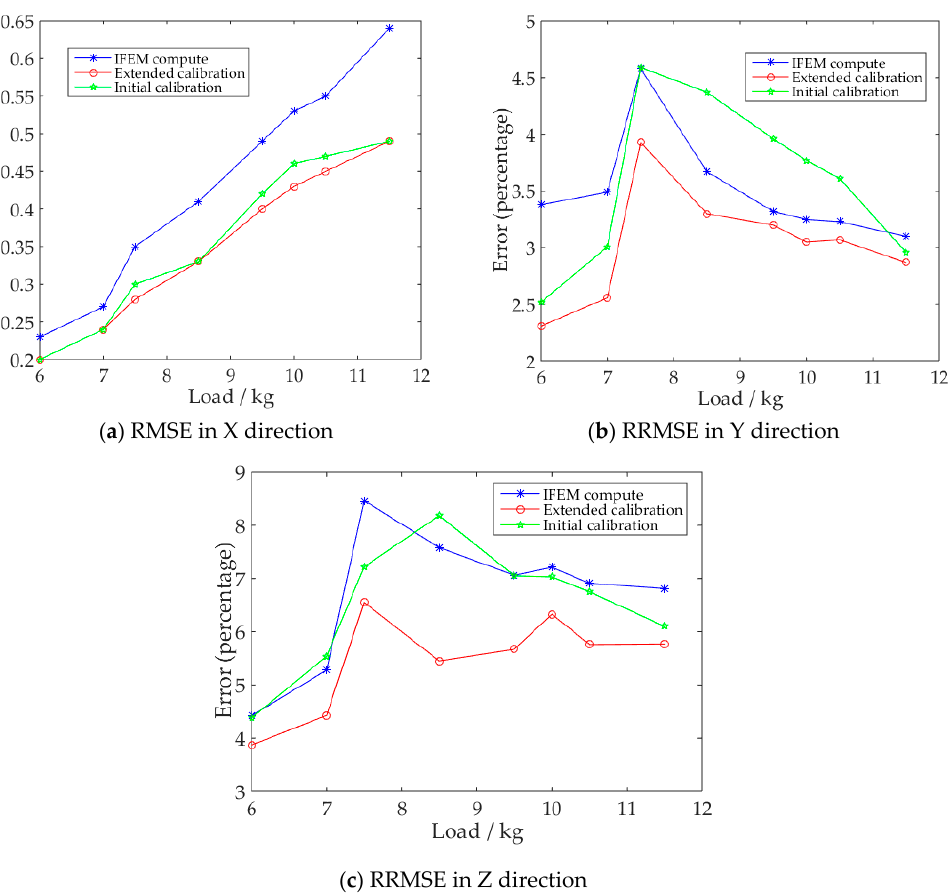
Figure 8. The overall x, y, and z direction errors of the three-element frame.